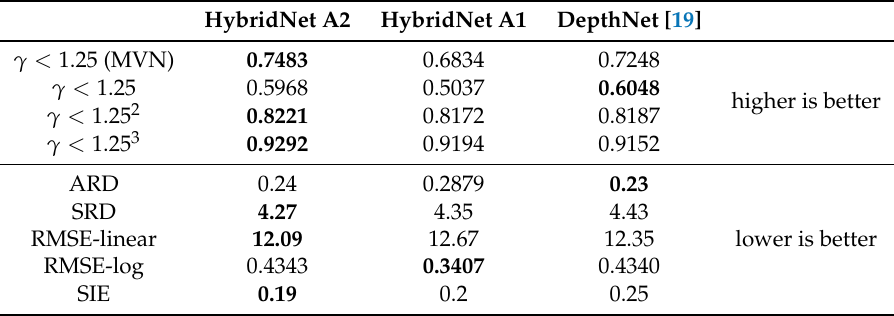
Table 4. Depth estimation. Quantitative evaluation: PP, PP-MVN, ARD, SRD, RMSE-linear, RMSE-log, and SIE (best results in